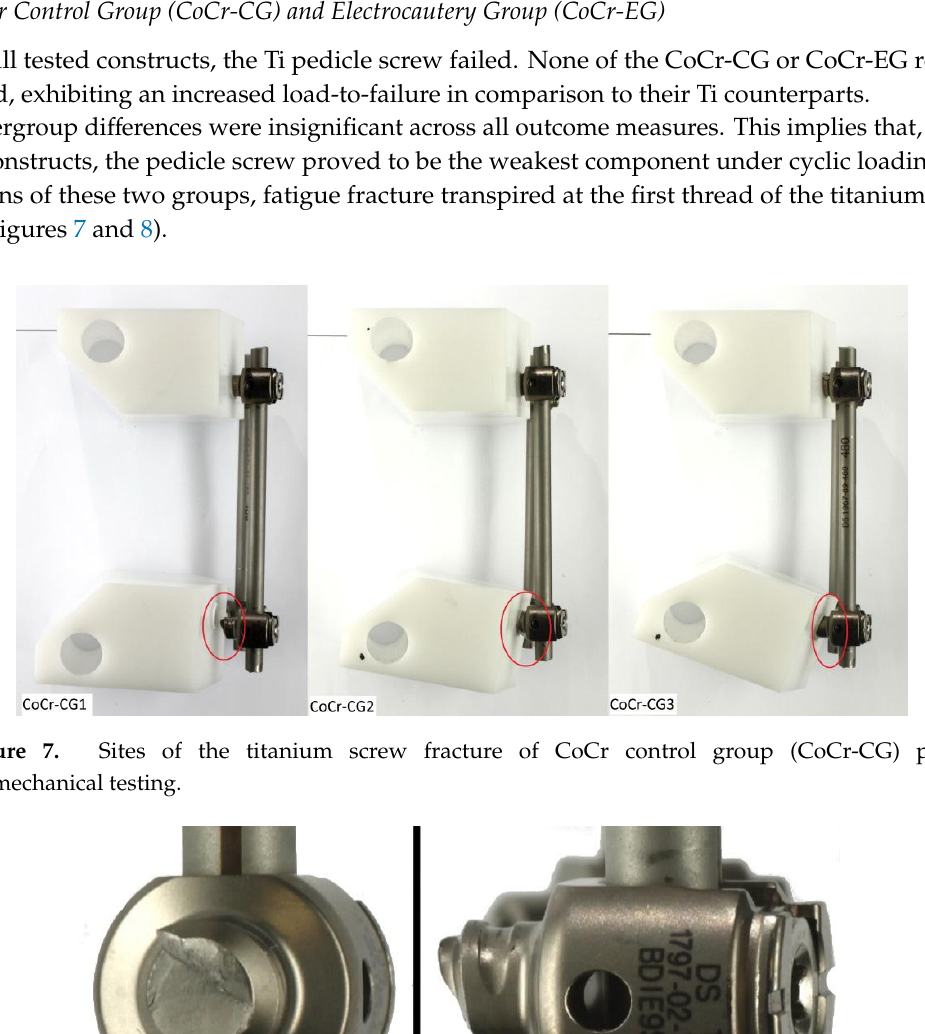
Figure 8. Magnified frontal ( a ) and lateral ( b ) views of the titanium screw fracture of one of CoCr electrocautery group constructs (CoCr-EG 3)